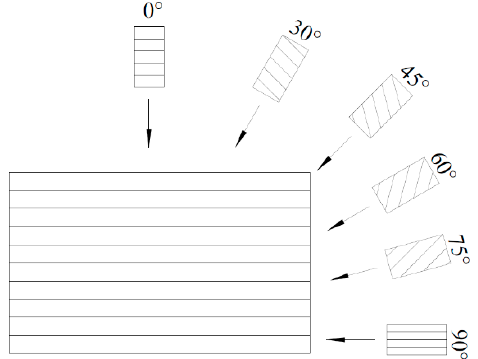
Figure 2. Angle relationship between the drill bit and the rock samples.